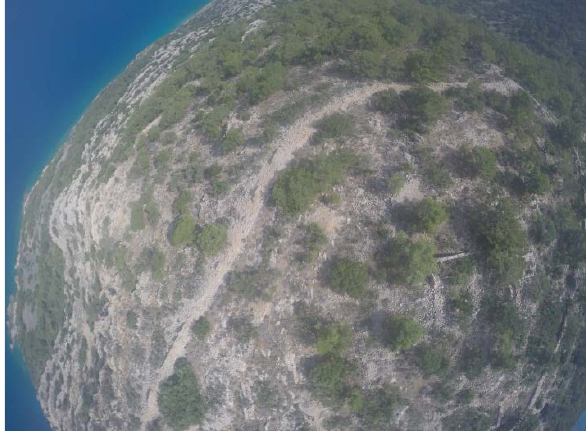
Figure 6. Aerial view of the castle on the highest hill of the island